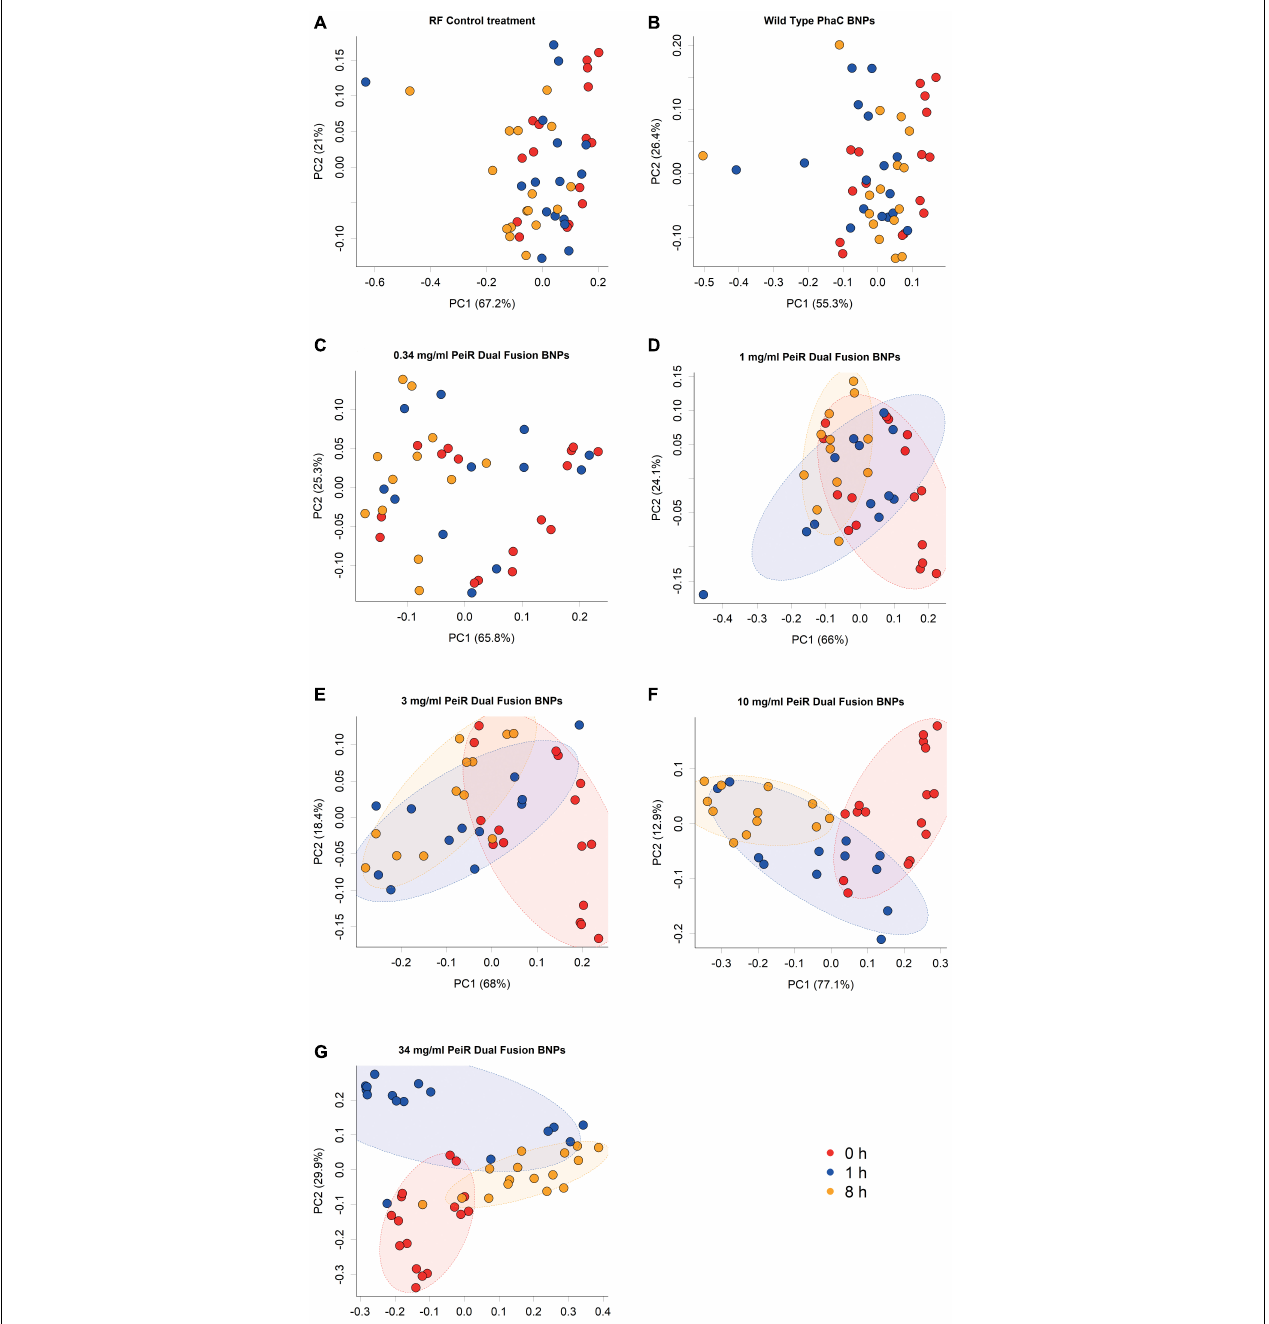
FIGURE 2 | Principal component analysis of archaeal communities. Archaeal communities from in vitro batch cultivations were compared at different nanoparticle doses. The addition of non-functionalized nanoparticles did not lead to a change in community composition compared to the control (A,B) . Increasing concentrations of Dual-fusion PeiR nanoparticles (C–G) revealed a corresponding incremental shift in the community composition over 1 and 8 h. Colored dots represent individual measurements. Colors indicate sample time point (Red: t = 0 h; blue: t = 1 h; orange: t = 8 h). Colored ellipses indicate 75% confidence intervals.